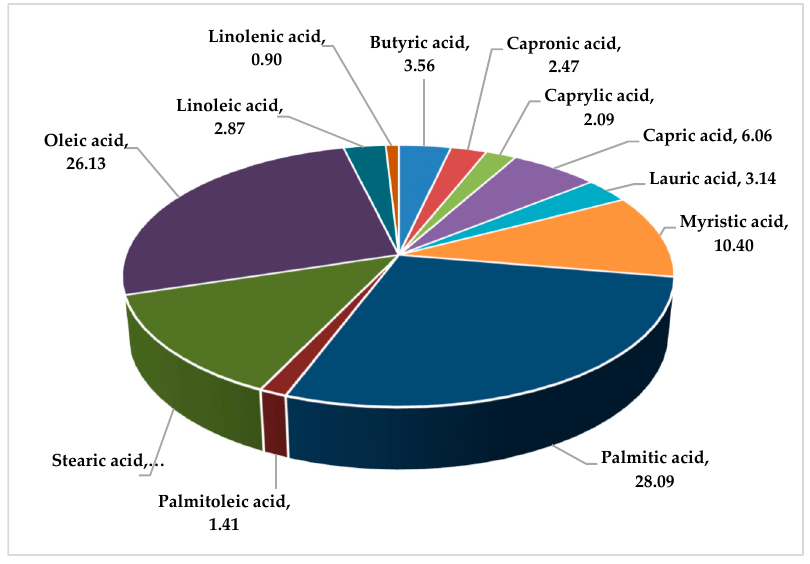
Figure 1 . Free fatty acids ( FFA) composition (% of total FFA) Fruhe cheese (mean of sheep and goat). Figure 1. Free fatty acids (FFA) composition (% of total FFA) Fruhe cheese (mean of sheep and